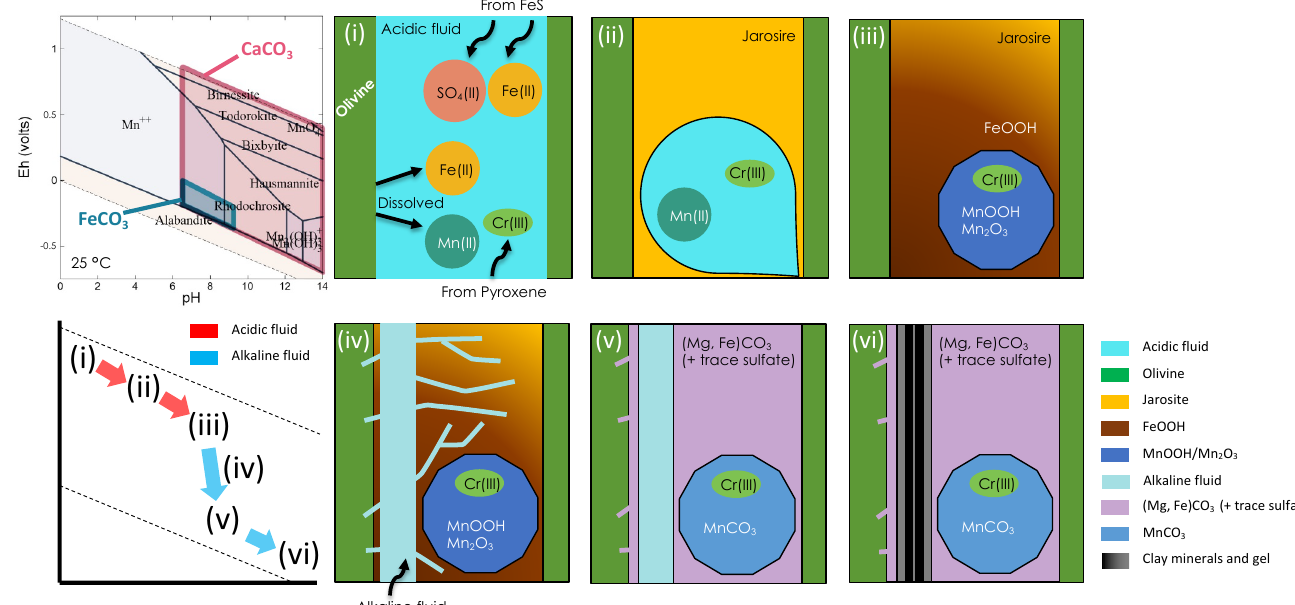
Figure 9. Schematic illustrations of the transition process in iddingsite based on